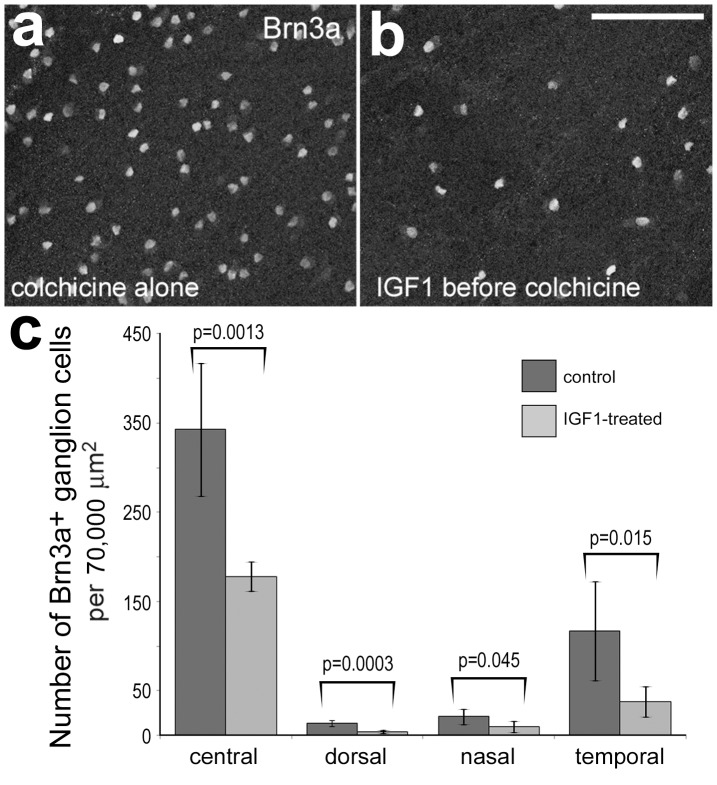
IGF1-treatment reduced the survival of colchicine-damaged ganglion cells.Retinas were obtained from eyes that were injected with saline (a) and colchicine (b) 10 days after treatment. Whole-mount preparations of the retina were labeled with antibodies to Brn3a to identify the nuclei of ganglion cells. Panel c is a histogram illustrating the mean number of Brn3a-positive ganglion cells per 70,000 µm2 in central and peripheral regions of the retina. Significance (p-values) of difference between numbers of Brn3a-positive ganglion cells in control and treated retinas was determined by using a two-tailed Student’s t-test. The scale bar (50 µm) in panel b applies to panels a and b.